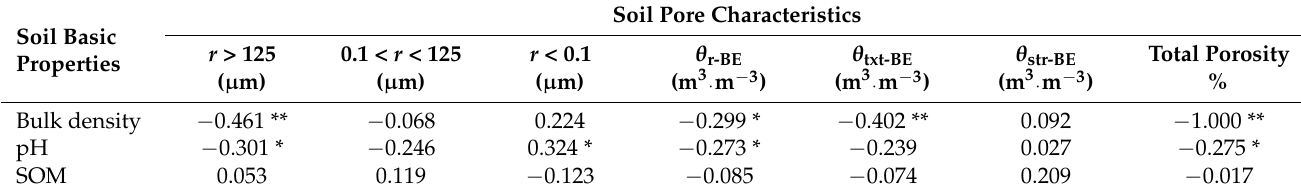
Table 5. Correlations of basic soil properties with soil pore characteristics at 0–40 cm soil for all studied plots.